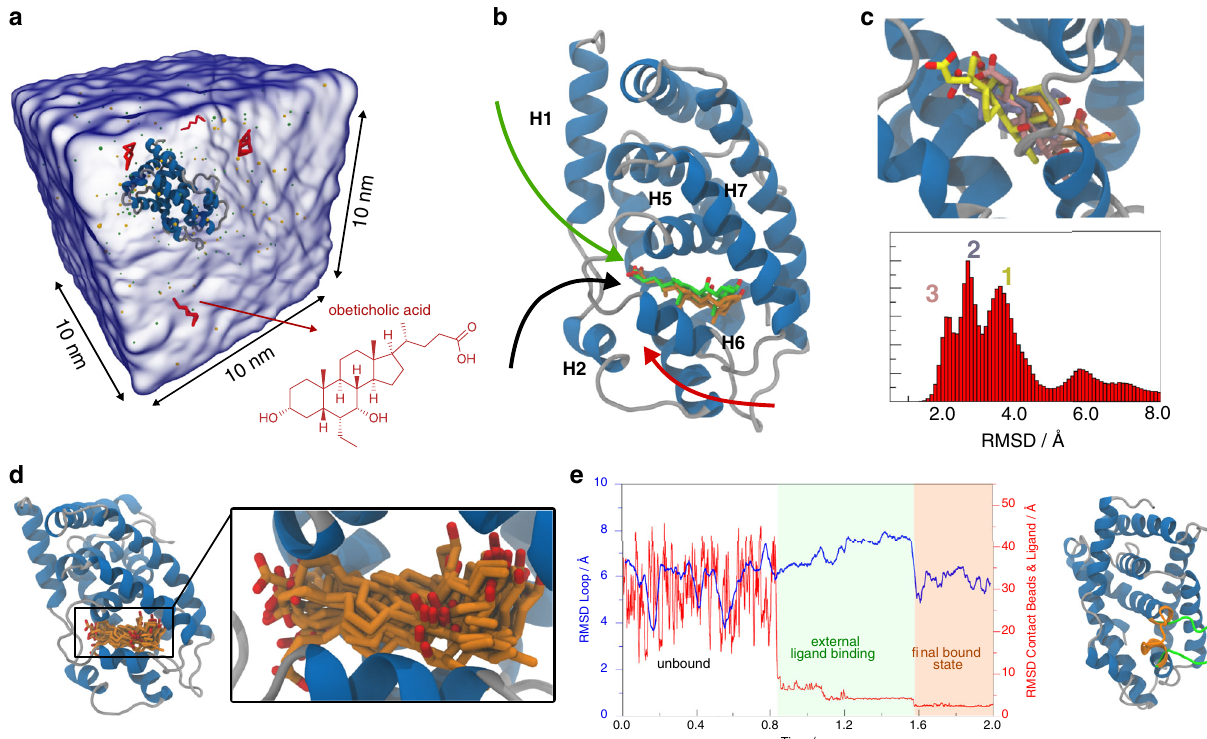
Fig. 3 Unbiased simulations of obeticholic acid binding to FXR at the CG Martini level. a Simulation box containing FXR and 4 obeticholic acid molecules (red) solvated in water (transparent blue surface). b Comparison of the crystallographic binding mode (green) and the best binding pose obtained from the CG MD simulations after back-mapping (orange). The protein is depicted in cartoon with random coils and turns colored in silver and alpha helices in blue. The molecules are shown in licorice with oxygens in red and carbon atoms in green or orange. The dominant binding pathways are shown as black, red, and green arrows. c Histogram of RMSD of all the binding poses observed during the simulations. The peaks at 3.6, 2.7, and 2.0 Å are denoted by the numbers 1, 2, and 3, respectively. Atomistic details of the centroids of peak 1 (yellow), 2 (ice-blue), and 3 (pink) are depicted in the protein binding pocket. d Multiple binding poses of obeticholic acid obtained from the CG simulations. Only structures with an RMSD below 2.3 Å with respect to the crystallographic ligand- binding mode are shown. e Evolution of the RMSD of the contact beads and ligand (red solid line) and the RMSD of the loop connecting helices 5 and 6 (blue solid line) during ligand binding. The plot is divided in three regions: the unbound, the external ligand binding, and the fi nal bound state for the sake of clarity. The inset on the right shows the loop conformation in the external ligand binding (green) and fi nal bound state